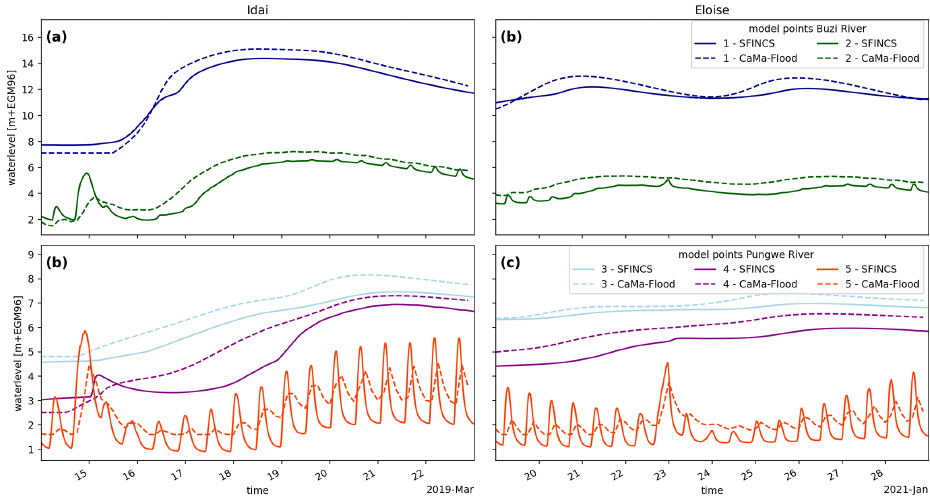
Figure 5. Simulated time series of water levels during Tropical Cyclone Idai (a, c) and Tropical Cyclone Eloise (b, d) with SFINCS (solid lines) and CaMa-Flood (dashed lines) for two locations in the Buzi (a, b) and three in the Pungwe (c, d) . See diamonds in Fig. 4 for the exact model output point